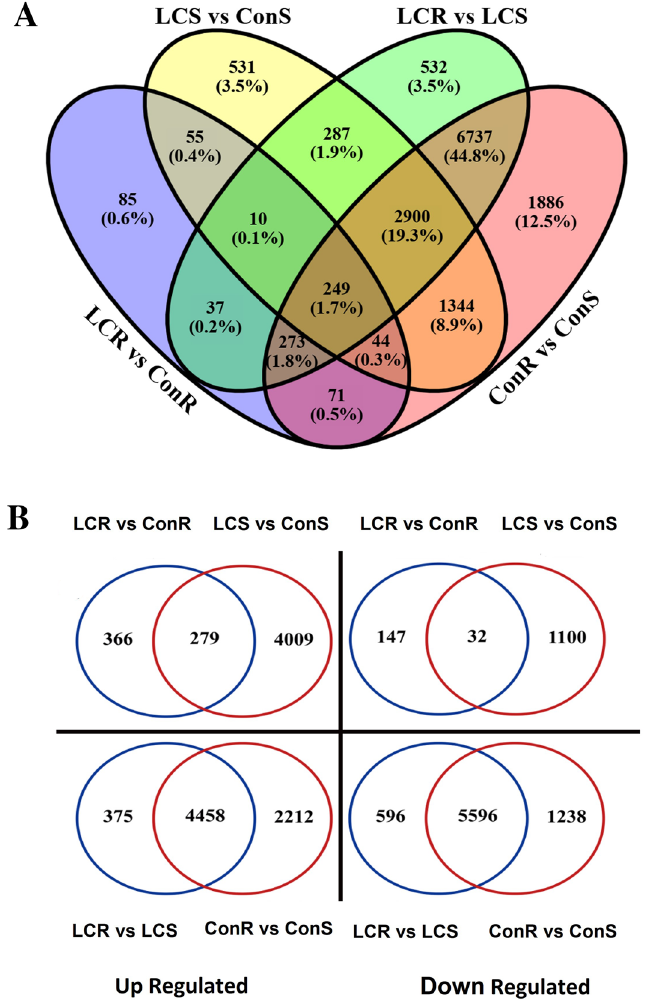
Figure 3. Transcriptomic response of tef in response to Ca 2+ treatment. ( A ) Venn diagram illustrating the number of DEGs between the two Ca 2+ treatment groups in root and shoot tissues, and ( B ) Venn diagram illustrating the number of differentially expressed genes between different treatment group. The treatment groups are LCR versus ConR, LCS versus ConS, LCR versus LCS and ConR versus